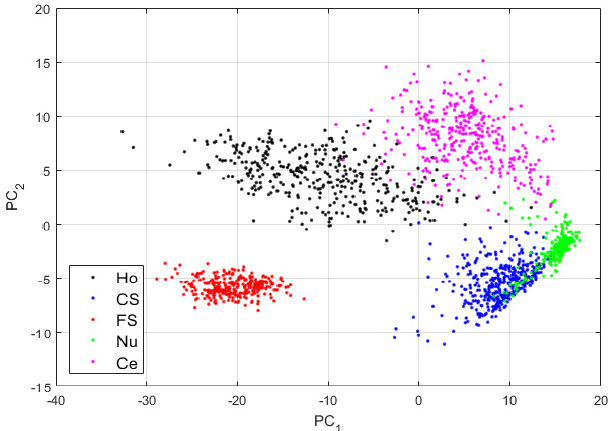
Figure 8. Visualization of the features learned by the DCAE in case ‐ 2. “Ho”, “CS”, “FS”, “Nu”, and “Ce” represent the homogeneous, coarse speckled, fine speckled, nucleolar and centromere cells, respectively. The percentages of the variance explained are, respectively, 83.06% and 16.38% for the first and second principal components.